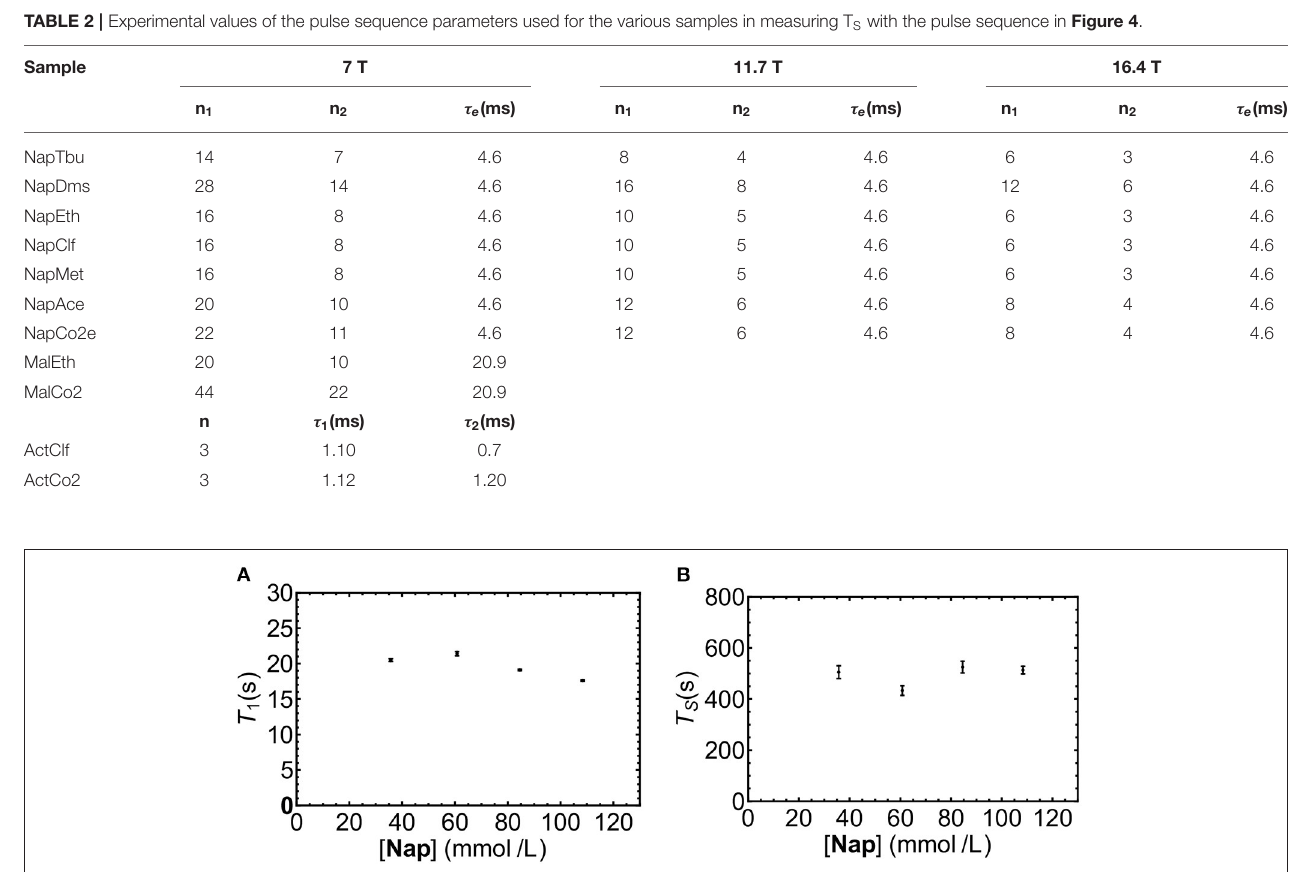
FIGURE 5 | T 1 (A) and T S (B) for Nap dissolved in liquid-CO 2 at different concentrations (samples NapCo2a-d in Table 1 ).